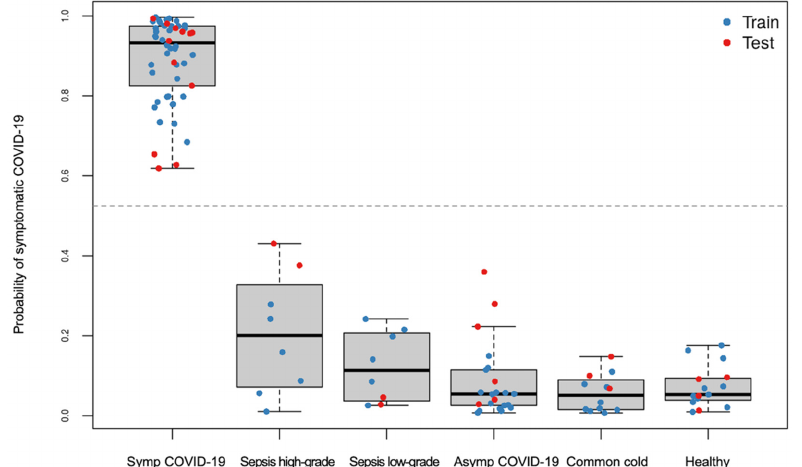
Figure 11. Predicted probabilities of symptomatic COVID-19 generated from LASSO-regularized logistic regression model, stratified by true phenotype group, and colored by training or testing set assignment.